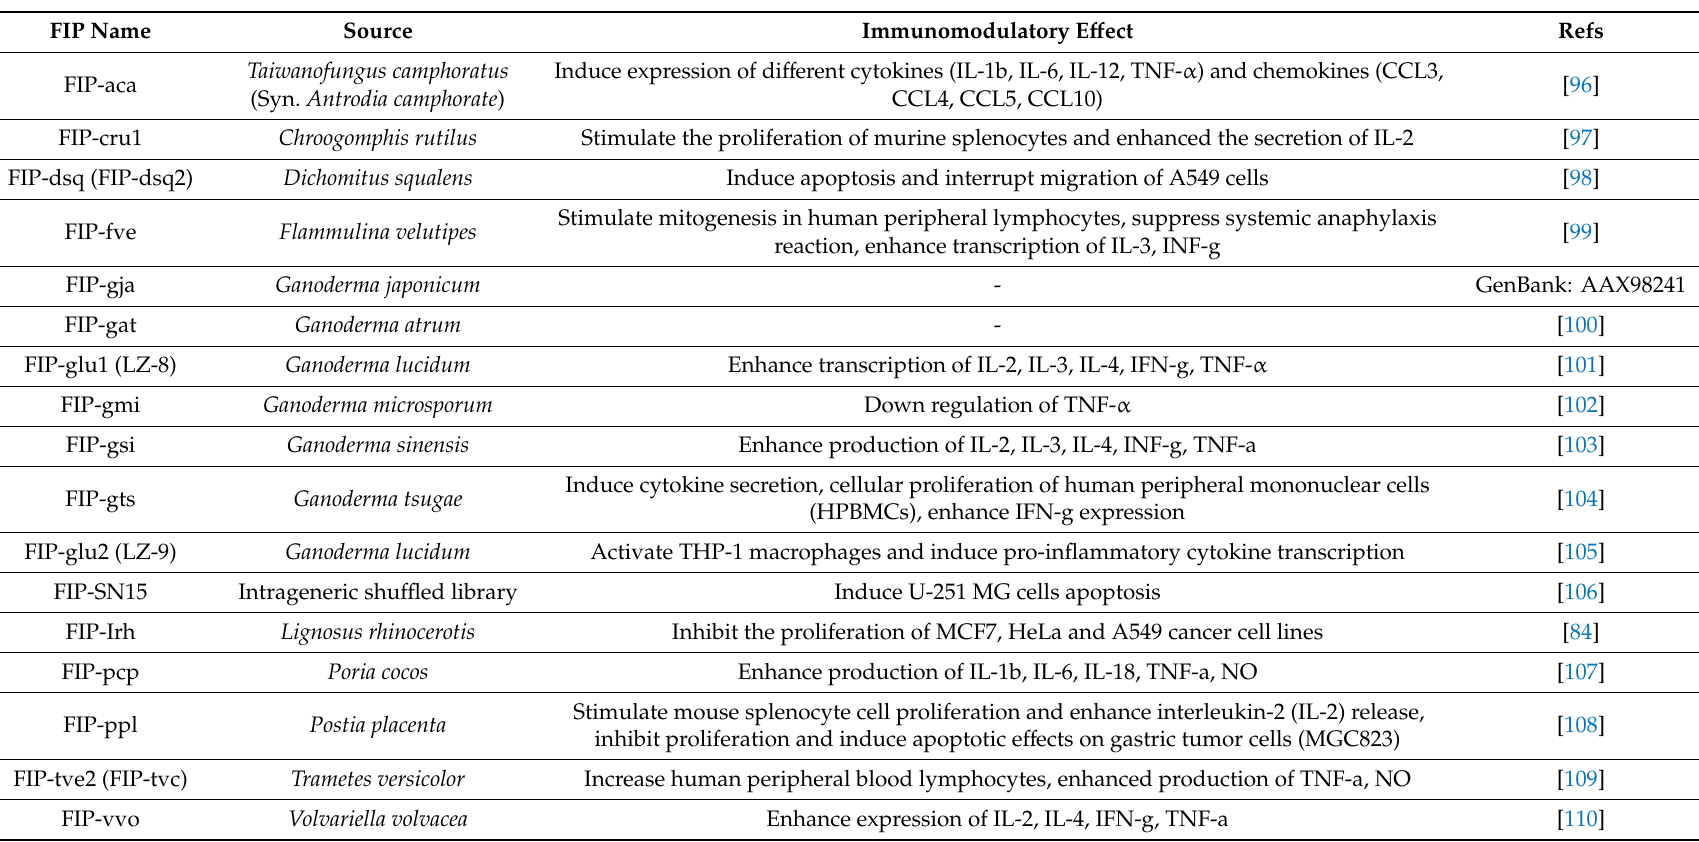
Table 4. Major fungal immunomodulatory proteins (FIPs) from medicinal mushrooms and their immunomodulatory e ff